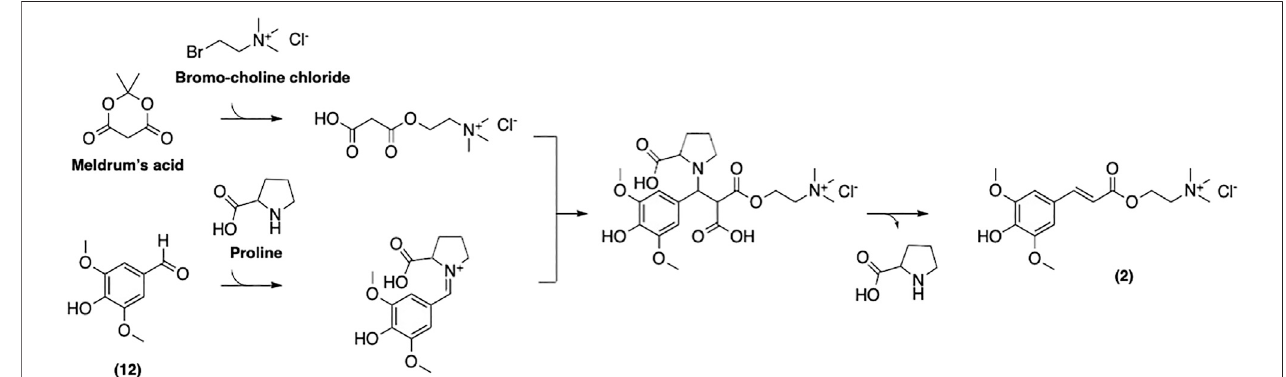
FIGURE 12 | Synthesis of sinapine described by Mouterde et al.